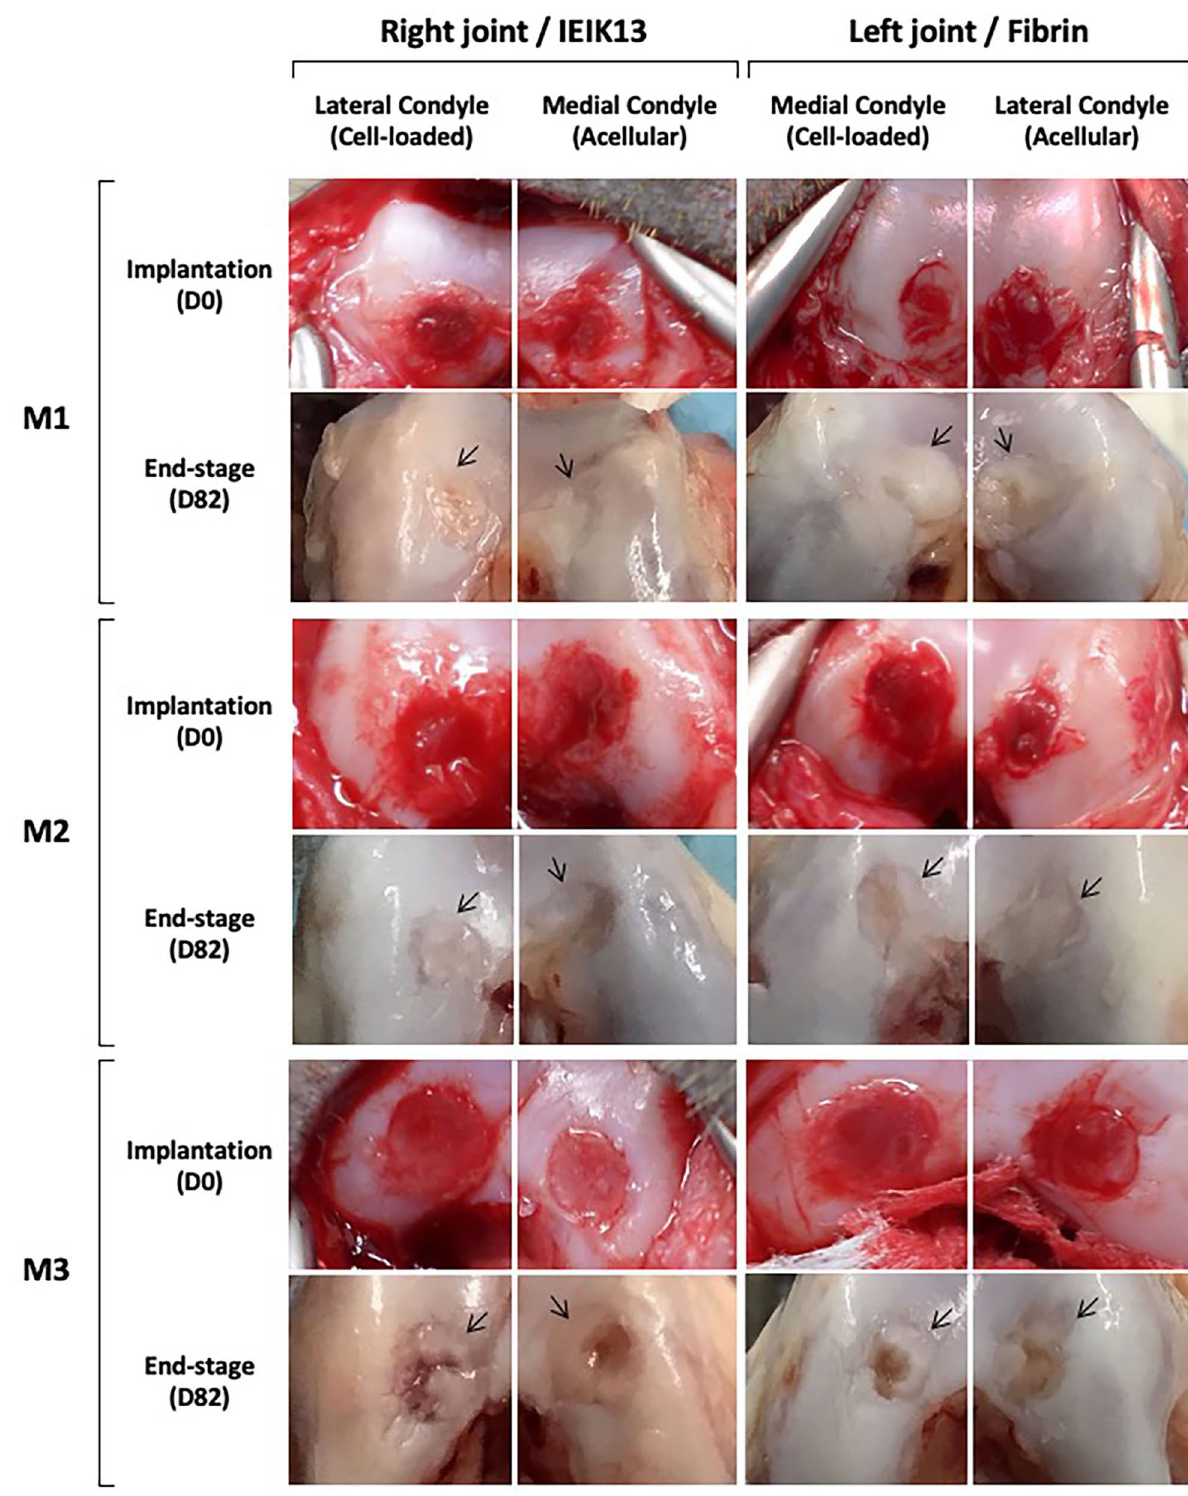
Figure 3. Macroscopic observations of the cartilage defects filled by IEIK13- and fibrin-based hydrogels at the day of implantation (D0) and 82 days after implantation (D82). The hydrogels were loaded or not with chondrocytes, as indicated. The anatomical site of implantation in the knee joint is specified and M1, M2 and M3 correspond to 3 Cynomolgus monkeys. The arrows indicate the original defect margin. The M1 and M2 defects appear globally well resurfaced whereas the central regions of M3 defects appear depressed or filled with rough